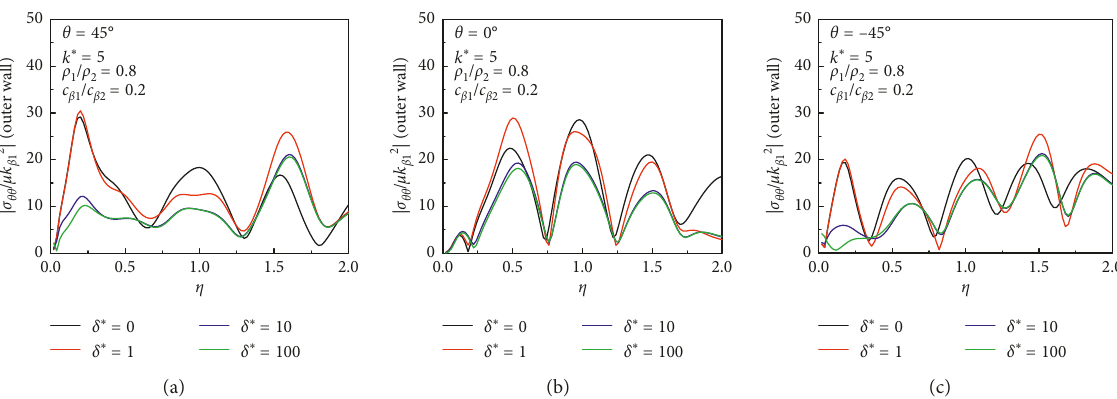
Figure 9: DSCF spectrum distribution on the outer lining wall surface under the vertically incident SV wave: (a) θ (c) θ 45 ° . (cid:29) −